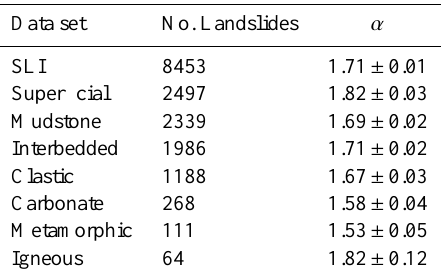
Table 1. Parameter estimates of power-law model for the entire SLI data set and subsets grouped by lithology. Power laws were fitted following Clauset et al. (2009) with error ranges reported as stan- dard errors.